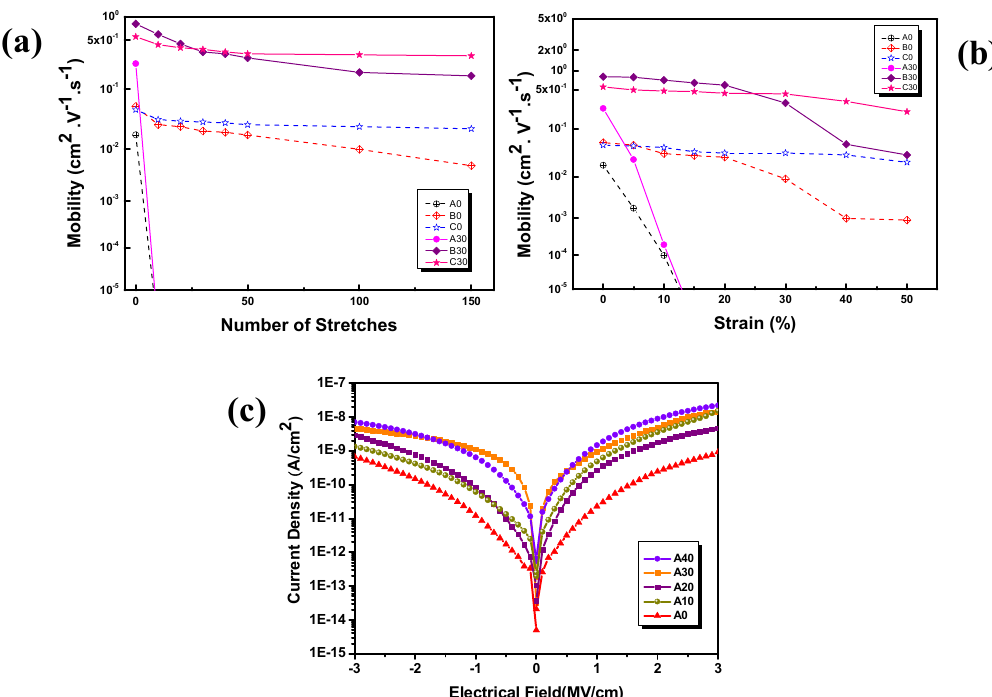
Figure 5. ( a ) mobility of the strained percentage, ( b ) the strained cycles and ( c ) leakage characteristics of hybrid thin films.